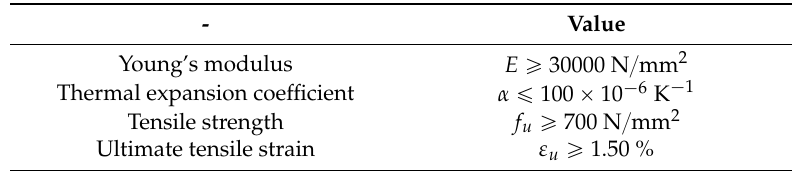
Table 1. Mechanical properties of GFRP (from the manufacturer).